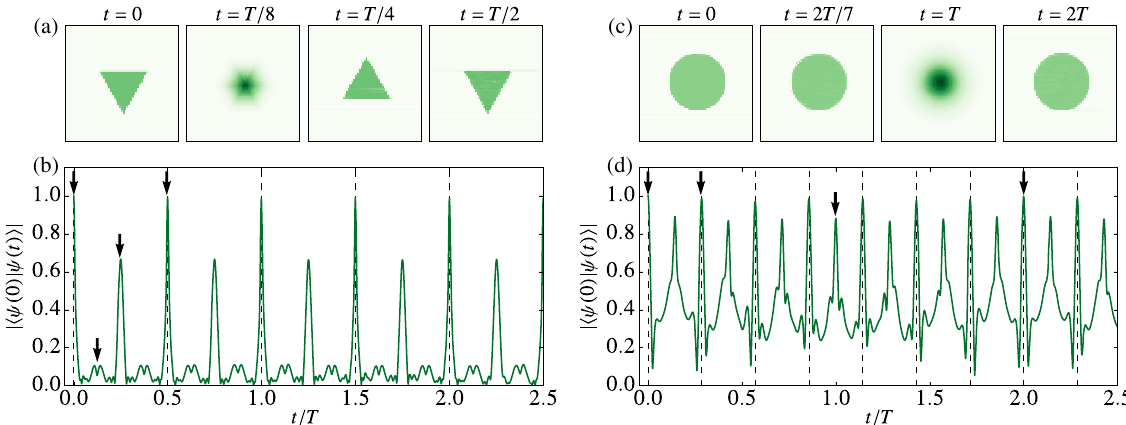
FIG. 6. (a) Calculated density distributions at times t=T ¼ 0 , 1 = 8 , 1 = 4 , 1 = 2 and (b) calculated time evolution of jh ψ ð 0 Þj ψ ð t Þij starting from the ground state in a triangular box. The numerical integration of the Gross-Pitaevskii equation is performed on a 512 × 512 grid. The triangle is centered on the grid, with a side length equal to half the grid size. We choose ˜ gN ¼ 25 600 corresponding to an initial healing length ξ ≈ l , where l is the grid step. (c) Calculated density distributions at times t=T ¼ 0 , 2 = 7 , 1, 2 and (d) calculated time evolution of jh ψ ð 0 Þj ψ ð t Þij starting from the ground state in a disk-shaped box. The numerical integration of the Gross-Pitaevskii equation is performed on a 512 × 512 grid. The disk is centered on the grid, with a diameter equal to half the size of the grid. We choose ˜ gN ¼ 12 800 leading to an initial healing length ξ ≈ 2 l , where l is the grid step. In (b) and (d), the black arrows indicate the times corresponding to the snapshots presented in (a) and (c).